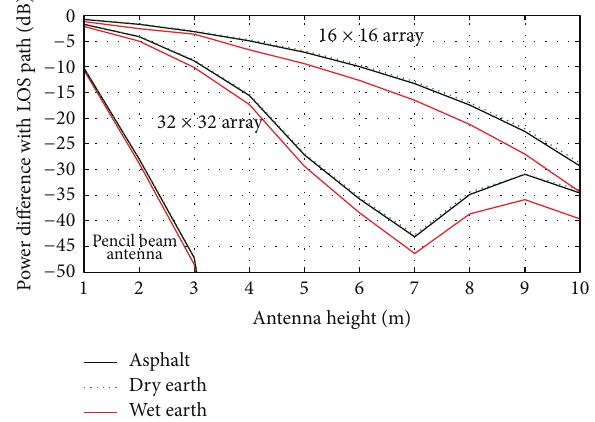
Figure 7: LOS-ground reflection power difference for different ground